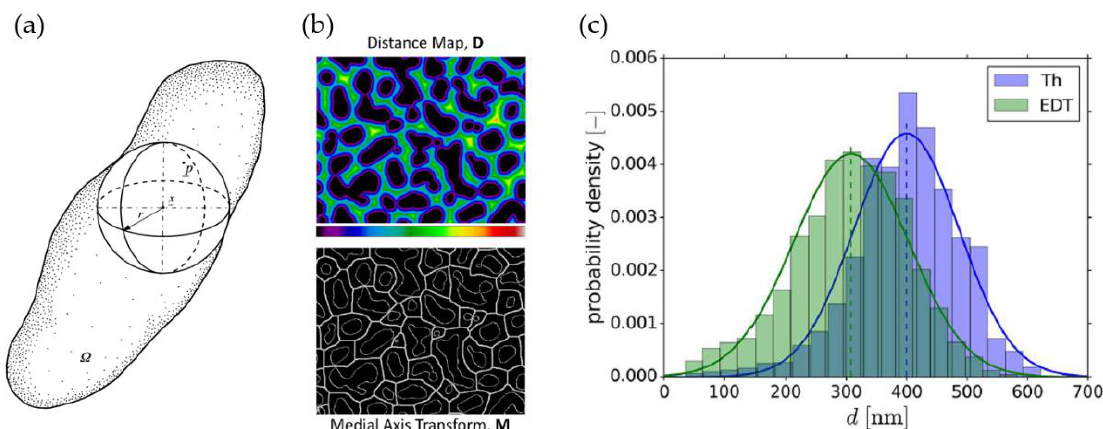
Figure 4. Schematic of thickness estimation algorithms ( a ) biggest-sphere Thickness (Th) by Hildebrand and Rüegsegger [63], ( b ) Euclidean Distance Map (EDT) and multiplication with the Medial Axis Transform (MAT) skeleton used by Stuckner et al. [44]. ( c ) Significant shift in the diameter distribution is observed using the Th and EDT algorithm on one tomography: average diameter (cid:104) d (cid:105) Th = 400 nm and (cid:104) d (cid:105) EDT = 308 nm by Richert et al. [53]. Reprinted from [63] with permission from John Wiley and Sons; [44] with permission from Elsevier; the author’s own work [53] published under Creative Commons Attribution License (CC BY 4.0).